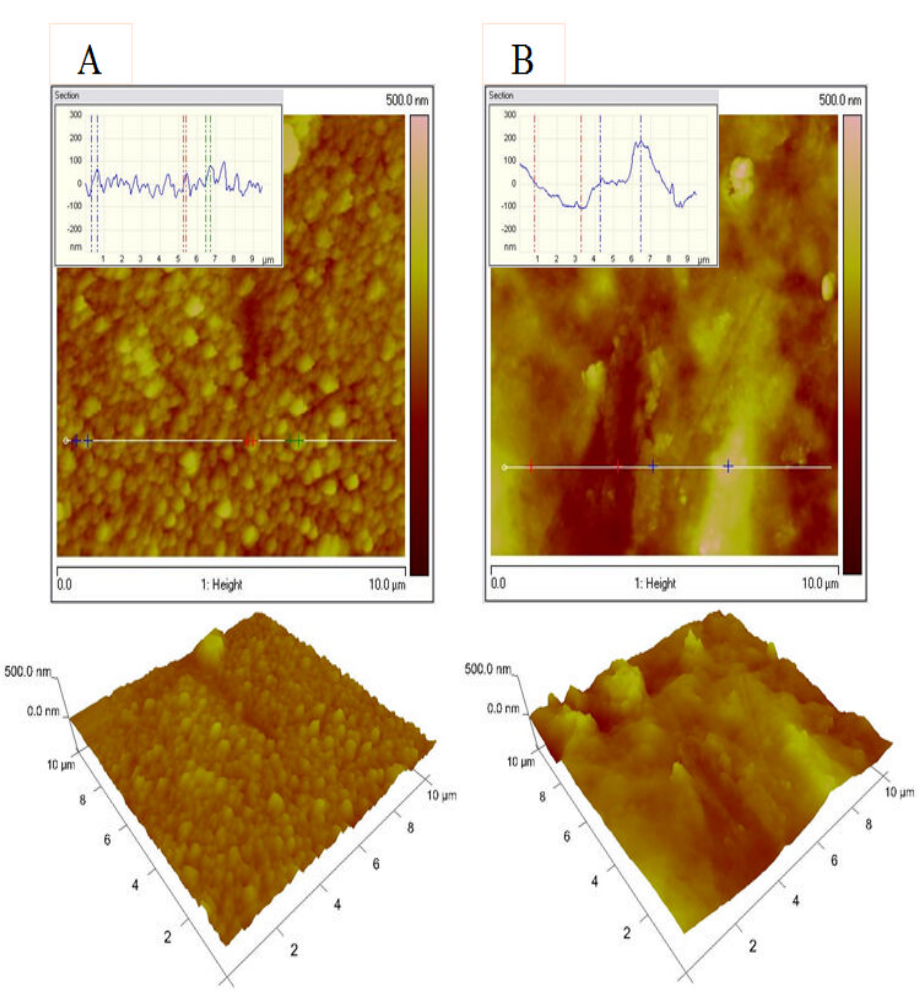
Figure 8. AFM topography of ordinary zinc ( A ) and hybrid zinc ( B ) coatings: 2D images, 3D images, and section analysis .